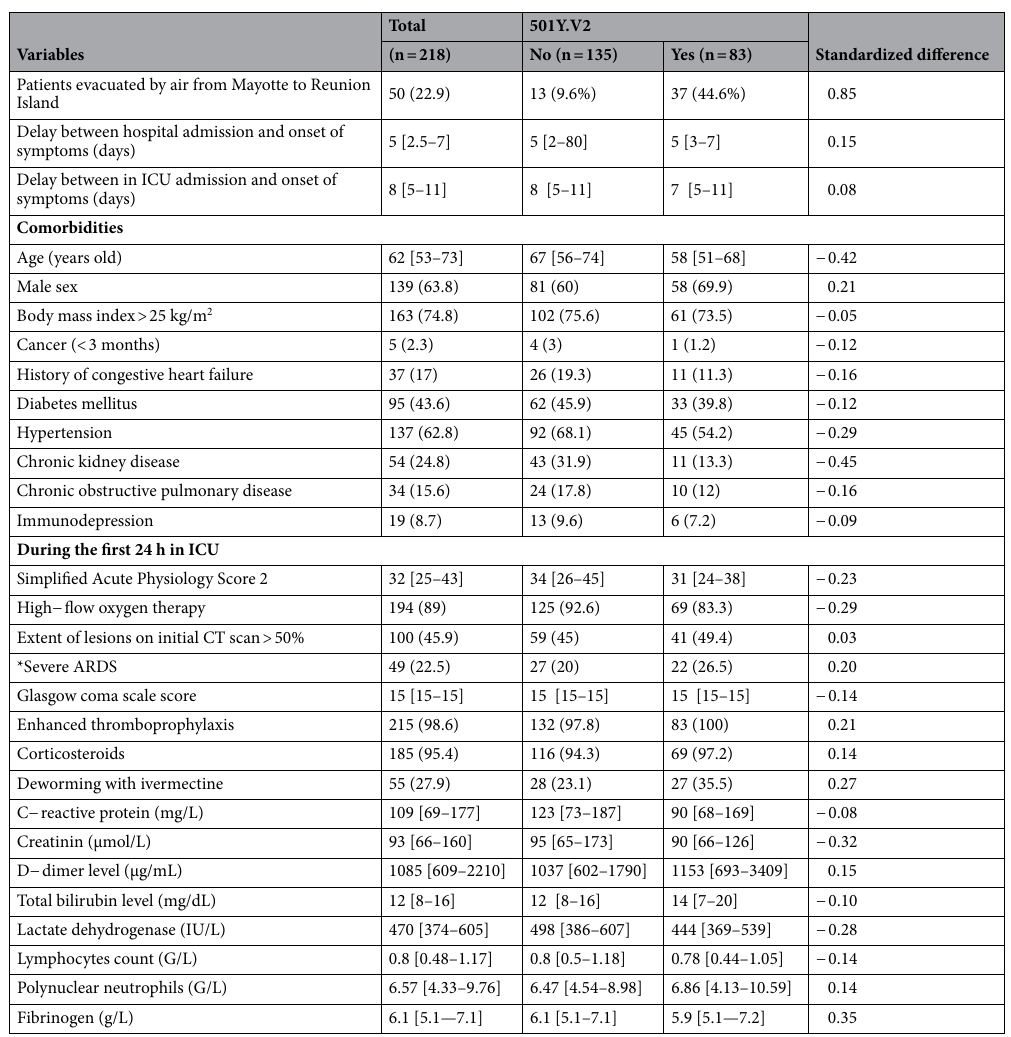
Table 1. Baseline patient characteristics in pre-matched groups. Results are expressed as total numbers (percentages) for categorical variables and as medians [25th–75th percentiles] for continuous variables as appropriate. ARDS acute respiratory distress syndrome, CT computed tomography, ICU intensive care unit. *Defined as PaO2/FIO2 ratio ≤ 100 mmHg with PEEP ≥ 5 cm